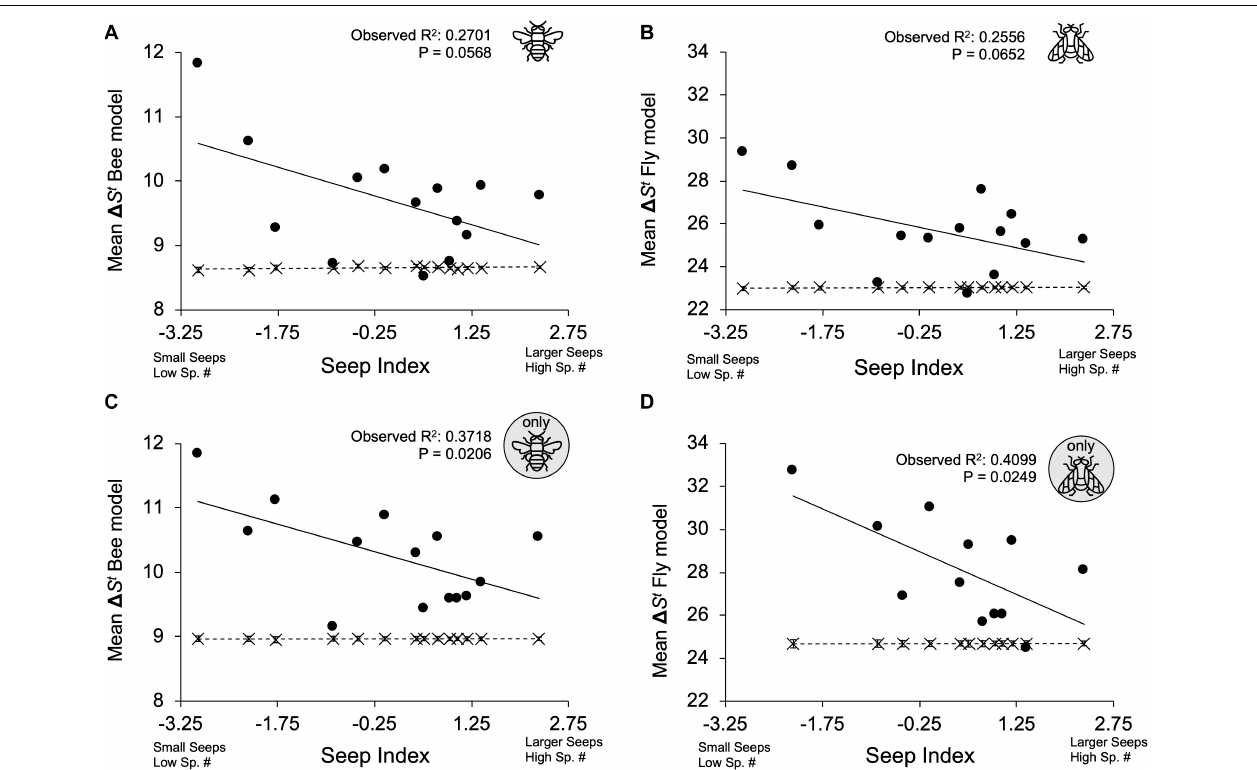
) and solid lines; (cid:32)